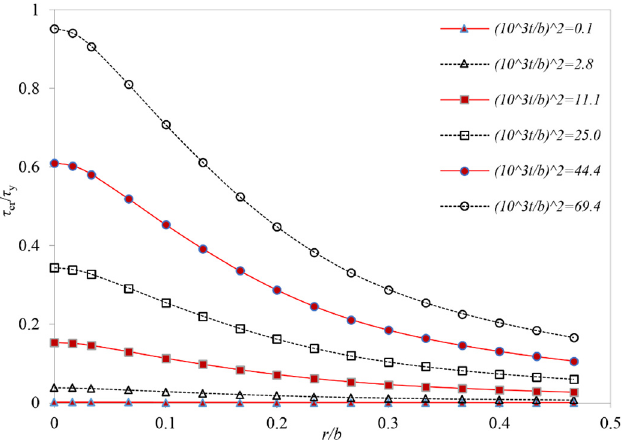
Fig. 7. Buckling of square plates with circular holes.